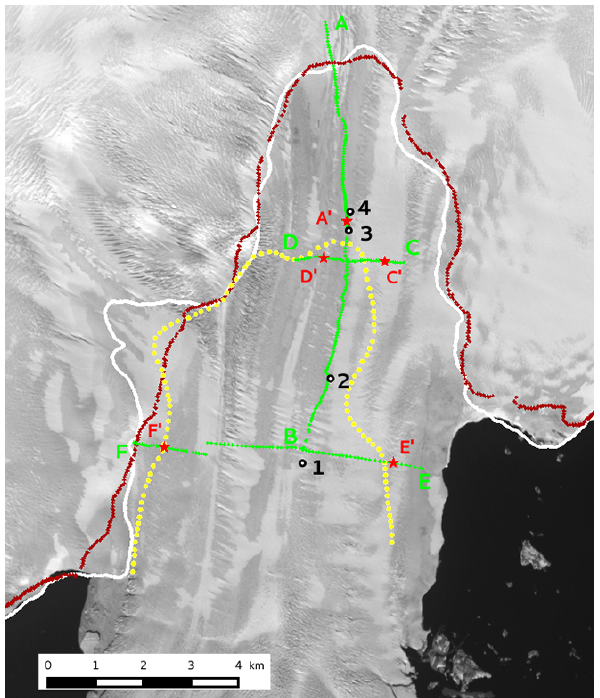
Figure 9. Profiles made of measurement points (green dots) where the ice upper surface was measured by GPS at both low and high tides. Also featured is the grounding line preceding estimation. Red stars (labelled A 0 , C 0 , D, E 0 and F 0 ) represent the transition points where this difference becomes significant (see text in Sect. 4.2.1) and points 1 to 4 are the points where GPS has been dropped and has been recording continuously during several tidal cycles (Sect. 4.2.2).